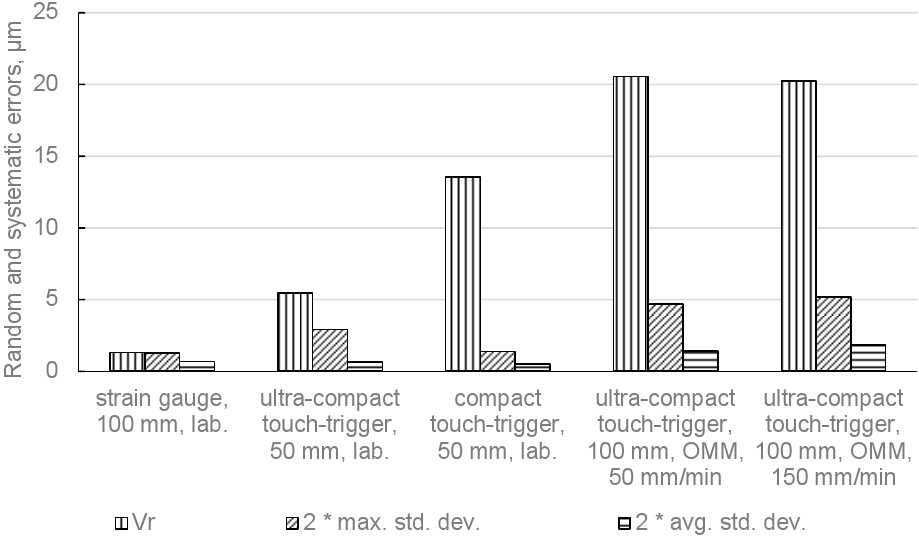
Figure 7. Random and systematic errors share vs. probe type and stylus length.